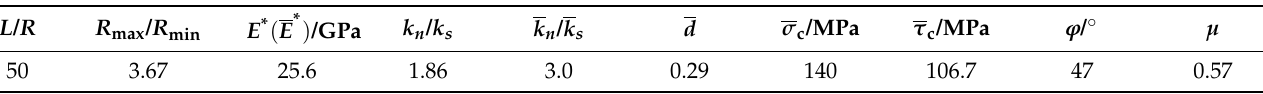
Table 11. Mesoscopic parameters of